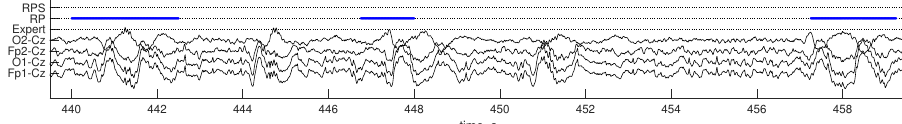
Figure 8. Dreams dataset. Lines represent the expert scoring (Expert), results of the benchmark (RP), and the proposed (RPS) methods.